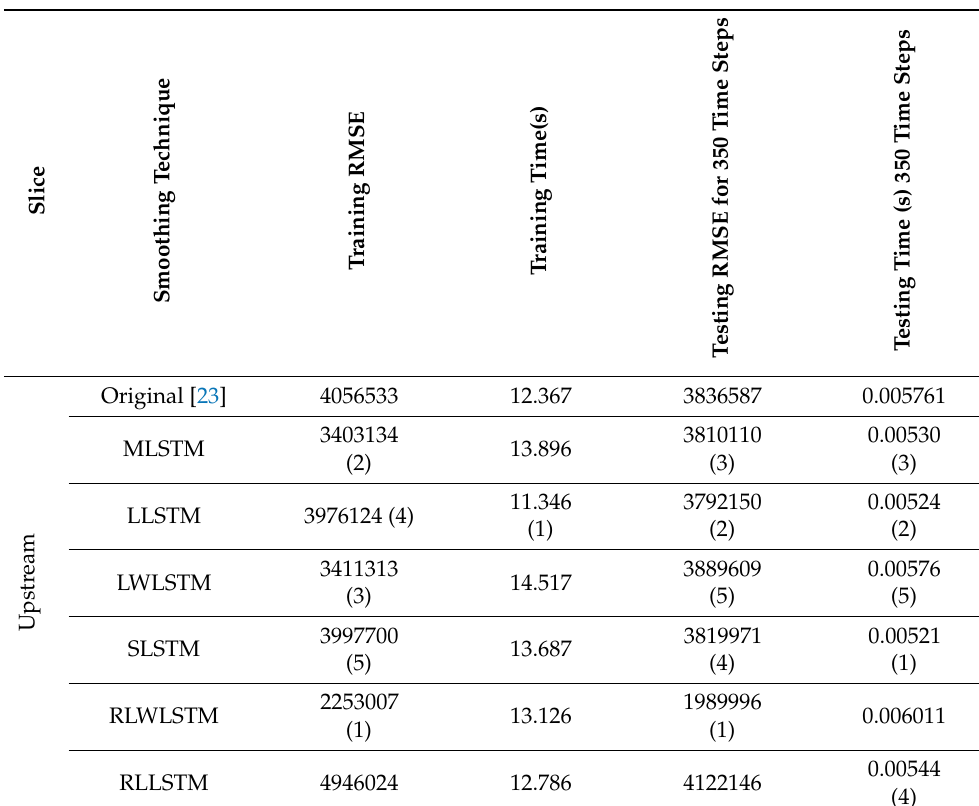
Table 7. Performance of combining local smoothing and